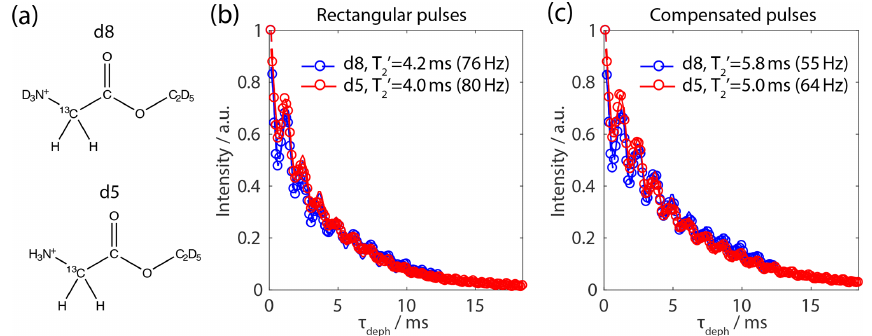
Figure 7. Quantification of the second- and third-order error terms in the FSLG pulse sequence. (a) Model compounds of glycine ethyl ester with an isolated CH 2 -spin system (d8) and protonated representing a multi-spin system (d5). (b) T (cid:48) FSLG decoupling on the protons during the echo time with rectangular pulses during the echo period and an effective-field angle equal to the magic angle. (c) The identical curves to (b) but using compensated pulses. The corresponding full width at half maximum is given in the figure legend. The MAS frequency was set to 14kHz with an effective field of 125kHz at an external magnetic field of 14.1T.